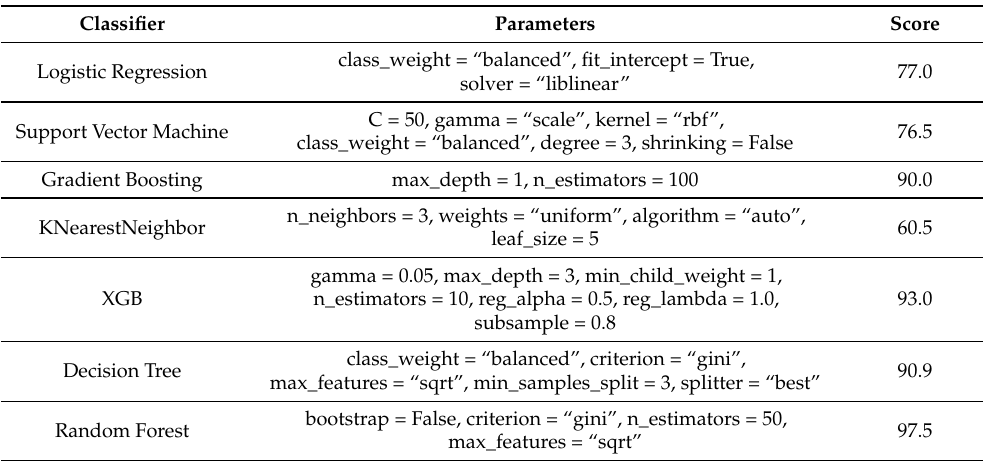
Table 6. Computed best parameters with obtained CV score for different